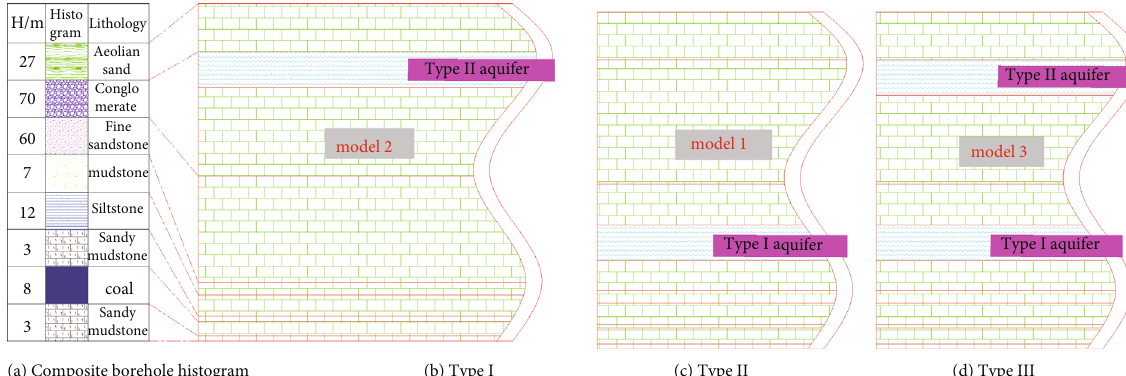
Figure 4: Generalization model for numerical simulation.